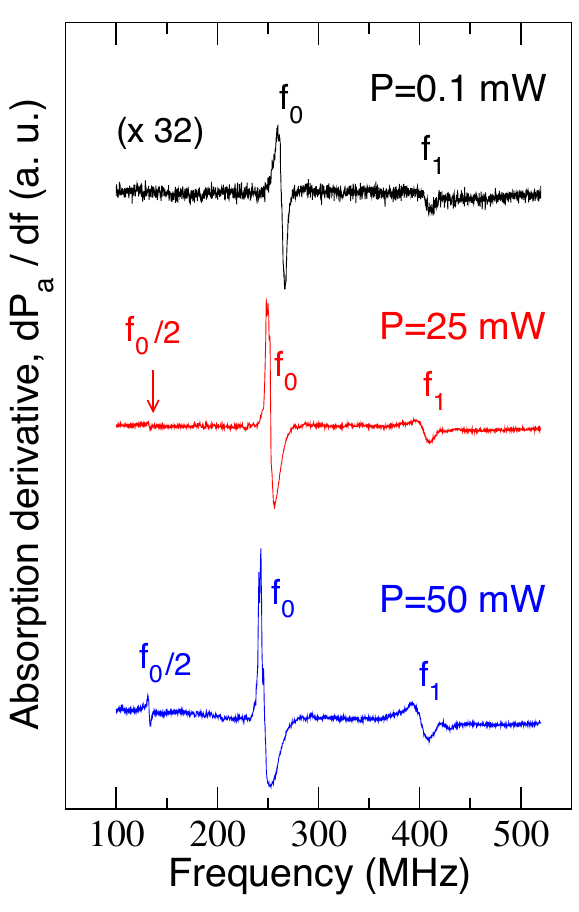
Figure 2. Experimental zero-field microwave power absorption spectra for three values of the input microwave power P = 0.1 mW (linear regime), 25 mW and 50 mW. The amplification factor is labeled in the parentheses. The resonance frequency for the fundamental Bloch DW resonance and the Néel DW resonance are located at f 0 and f 1 , respectively. The 1 / 2 subharmonic Bloch DW resonance appears at f 0 /